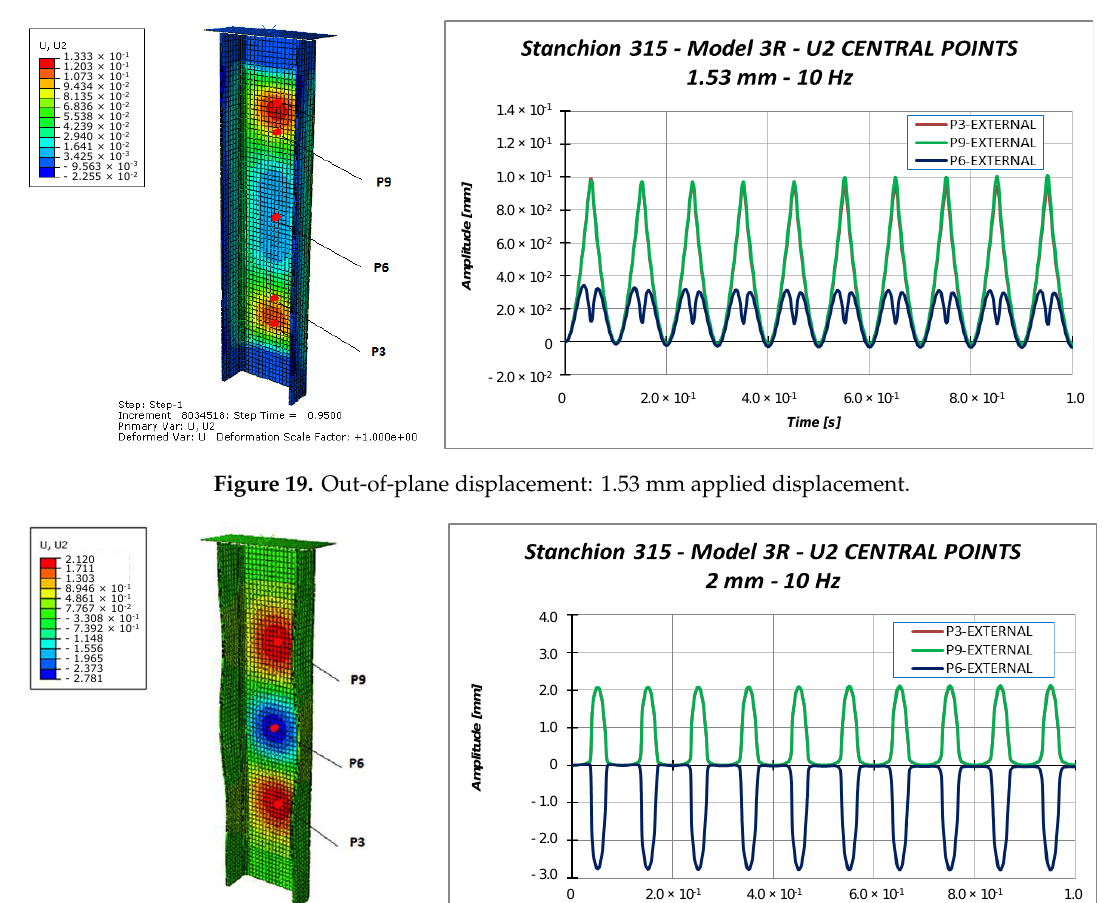
Figure 18. Out-of-plane displacement: 1.0 mm applied displacement.